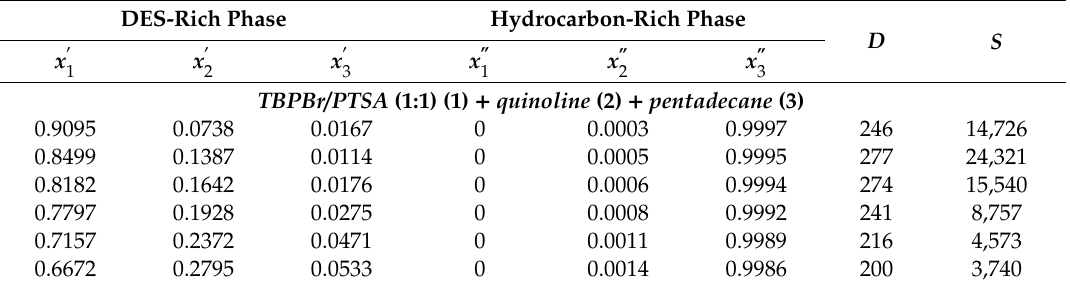
Table 5. Compositional analysis for systems containing quinoline, pentadecane, and DES TBPBr / PTSA (1:1) at room temperature along with distribution ratio, D , and selectivity, S